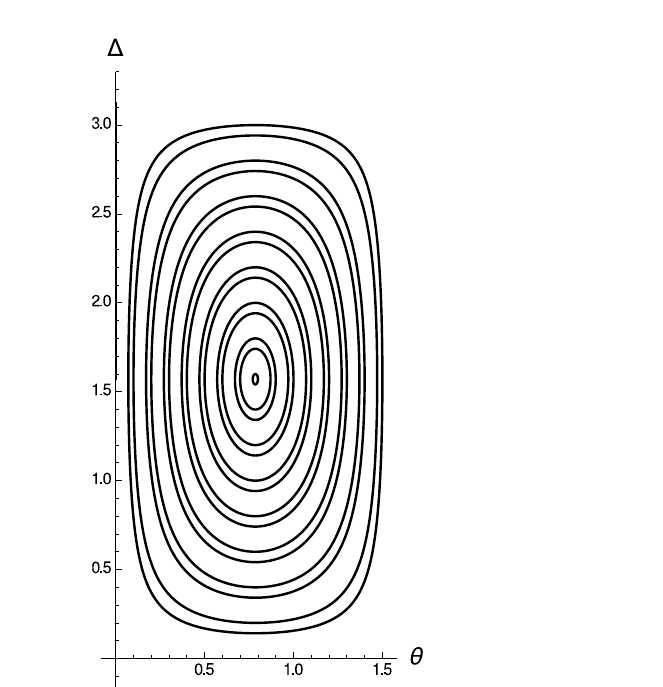
Figure 3. Orbits in the phase portrait of (10), where ( θ , ∆ ) ∈ [ 0, π